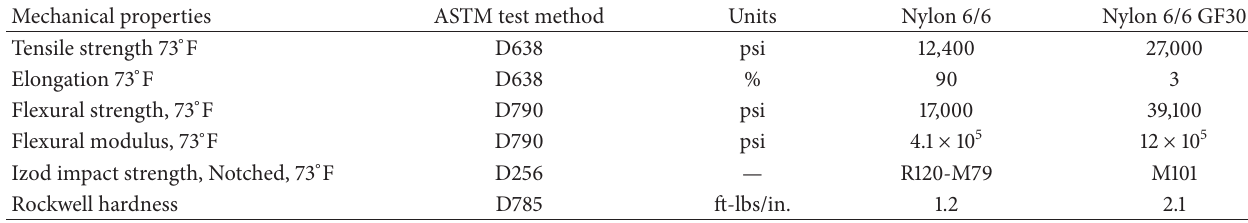
Table 2: Mechanical properties of Nylon-6 gear box.